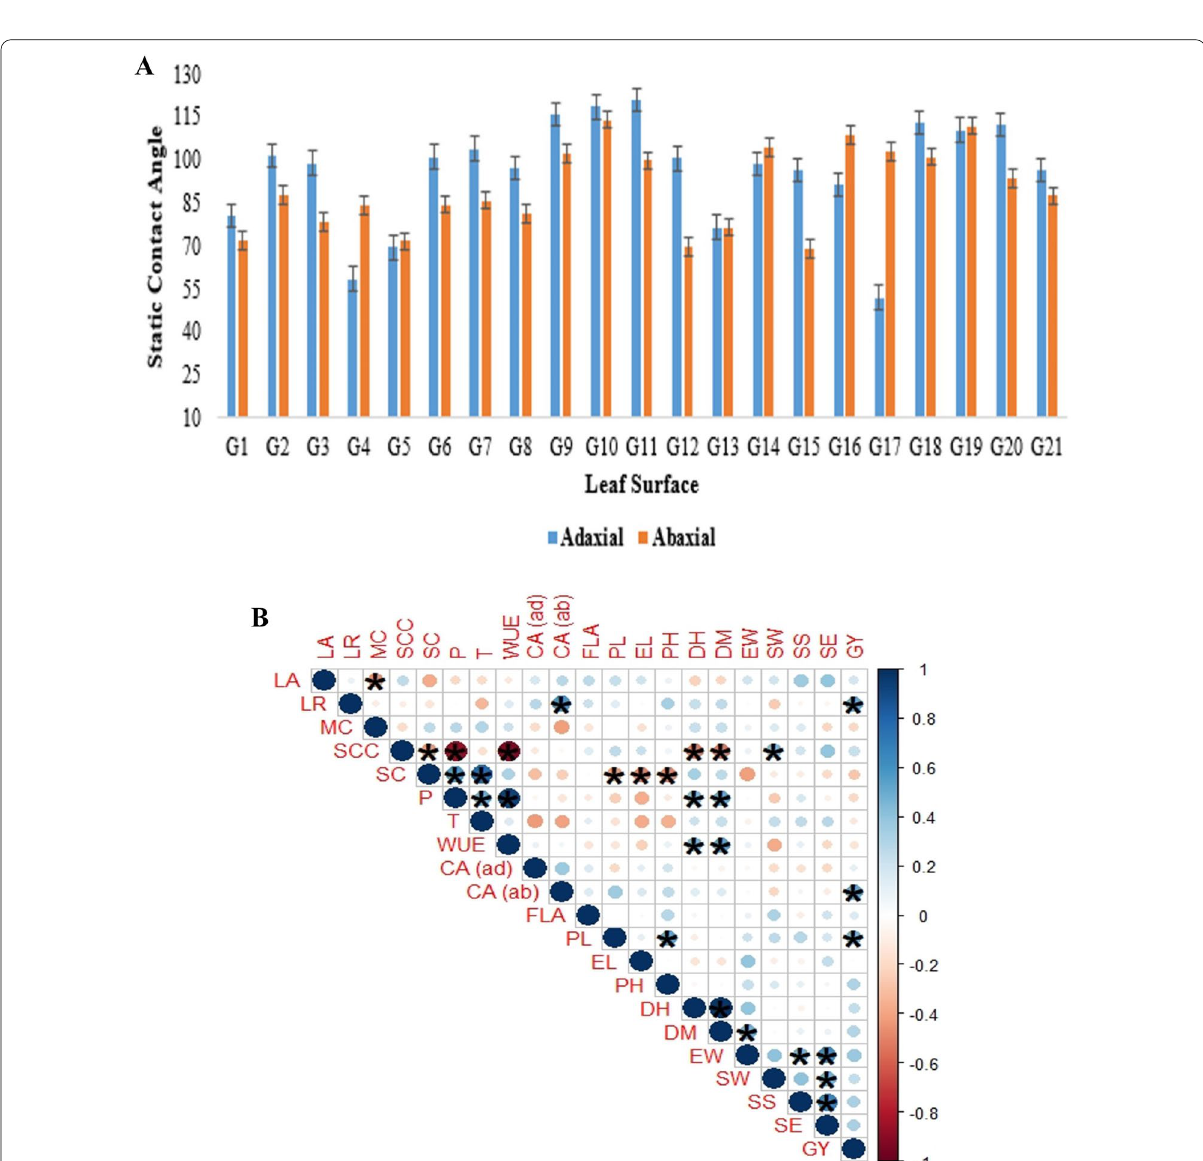
Fig. 8 A The static contact angle of the abaxial and adaxial leaf surface of 21 genotypes. Results are presented as mean of the mean). B Corrplot of leaf traits i.e. leaf rolling (LR) and leaf angle (LA), moisture capturing (MC), physiological parameters i.e. substomatal conductance (SCC), stomatal conductance (SC), photosynthesis (P), transpiration (T), and water use efficiency (WUE), and contact angle (CA) i.e. adaxial (ad) and abaxial (ab). The blue shade shows a positive correlation and the pink shade shows a negative correlation. The size of the circle shows strength of association with each other. * indicates significant (P < 0.05) and without sign (*) indicates non‑significant (P